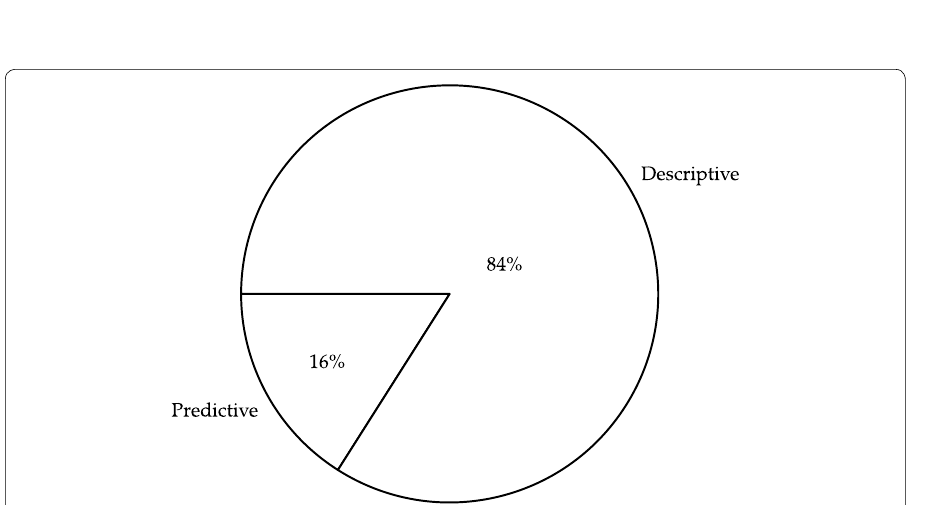
Fig. 7 Types of analysis. The figure depicts the percentage of the number of contributions that lend within the predictive and the descriptive types of